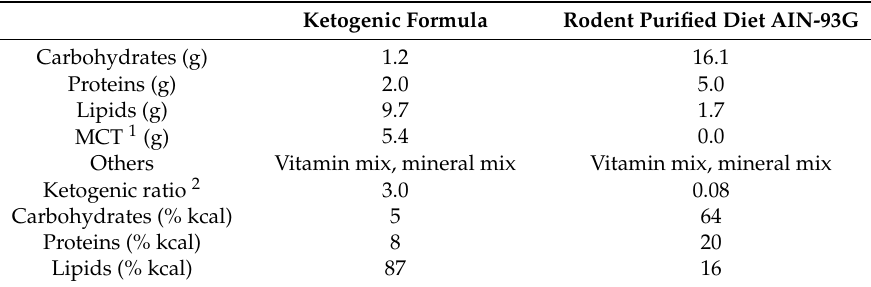
Table 1. Nutritional contents of the test diets (per 100